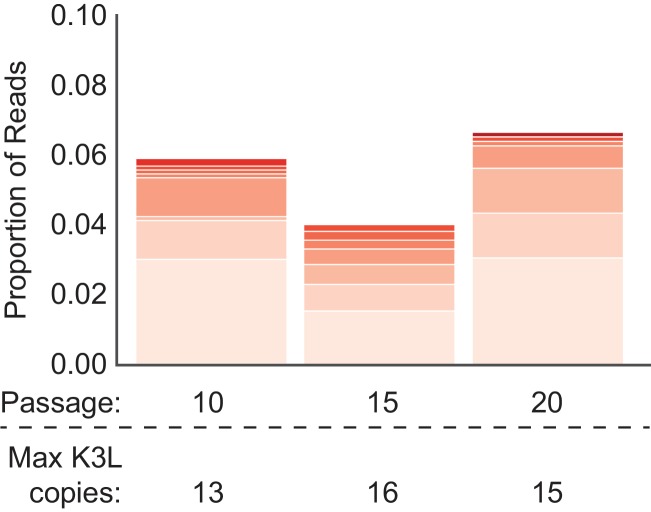
ONT reads capture high K3L copy number in vaccinia genomes.K3L copy number was assessed in ONT reads from P10, P15, and P20 as described in Figure 2C. Stacked bar plots indicate overall proportions of sequencing reads that contain between 6 and 16 copies of K3L, in ascending order (darker bars represent increasing copy number). The maximum copy number observed in any single ONT read is indicated below each passage.